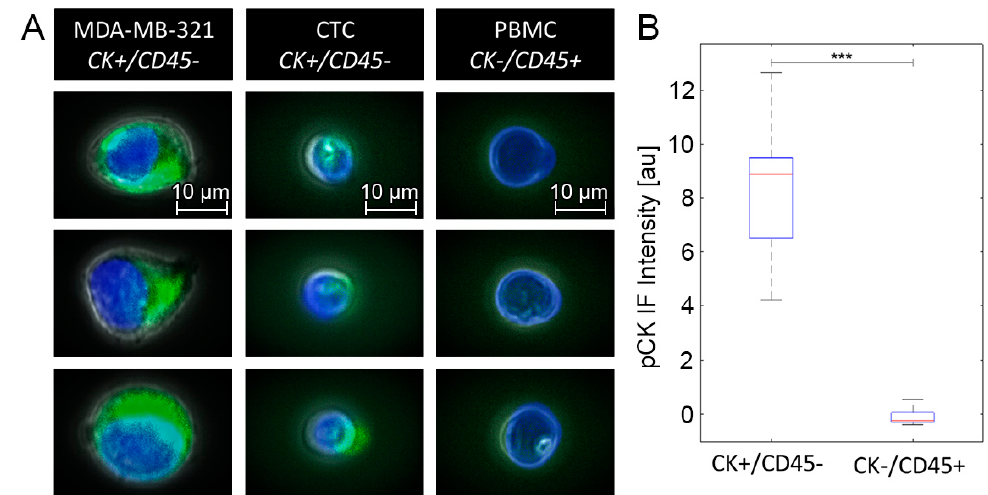
Figure A3. Overlay pictures of immunofluorescence staining using pan-cytokeratin (CK) antibody labeled with FITC dye (pseudo color green) and nucleic DAPI (pseudo color blue). MDA-MB 231 cells were used as a positive control for CK (green). Patient derived CTC candidates were indirectly enriched using CD45 depletion method as described above. Immunofluorescence staining against CK was carried out in the CD45 − depleted cell suspensions resulting in CK+/CD45 − cells. In addition, cells in the CD45 enriched suspension were stained against CK resulting in CK − /CD45+ cells (PBMC). Briefly, the staining method included fixation of the cells in ice-cold methanol for 5 min, washing in PBS, blocking in 5% BSA solution for 30 min, and binding of primary antibodies (final concentration 20 µL/mL) with FITC-conjugated mouse